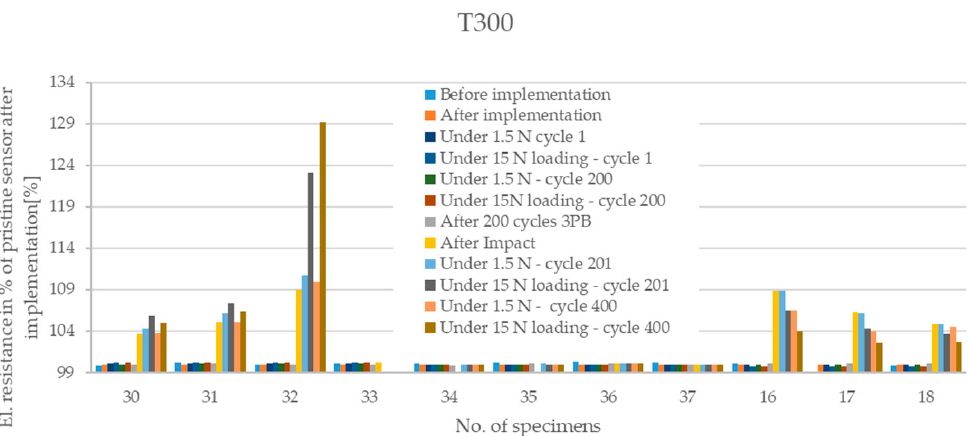
Figure 9. Electrical resistance of integrated sensors as a percentage of the value of a pristine sensor after implementation-results for specimens with CFSs made of material T300.